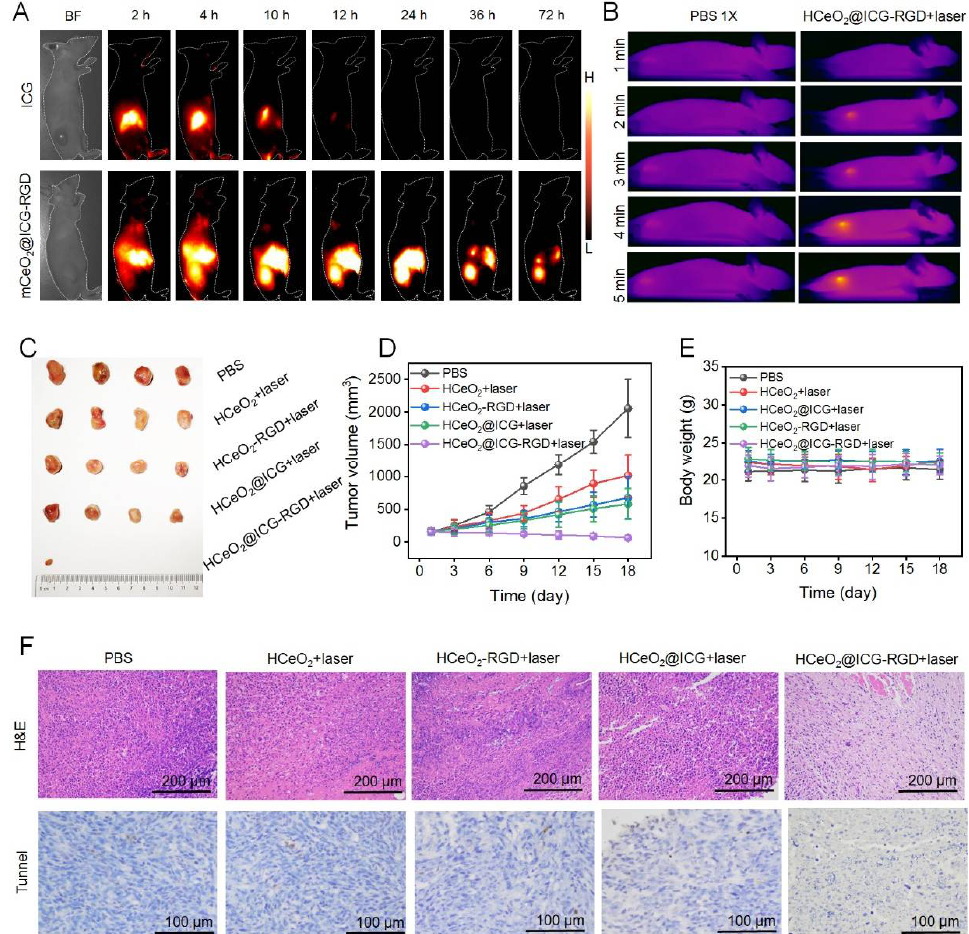
Figure 5. ( A ) NIR II fluorescent images of 4T1 breast tumor-bearing nude mice after tail vein administration of ICG or HCeO 2 @ICG-RGD at various times. ( B ) IR thermal images of 4T1 breast tumor-bearing nude mice under 808 nm laser (1 W cm −2 ) irradiation for different durations. Two groups of BALB/c nude mice were pretreated with tail vein administration of PBS or HCeO 2 @ICG-RGD at 24 h. ( C ) Digital image of dissected solid breast tumors after 18 days of treatment with PBS, ICG+laser, HCeO 2 -RGD+laser, HCeO 2 @ICG+laser, and HCeO 2 @ICG-RGD+laser. Tumor volume curves ( D ) and body weights measurement ( E ) of 4T1 breast tumor-bearing nude mice after PBS, ICG+laser, HCeO 2 -RGD+laser, HCeO 2 @ICG+laser, and HCeO 2 @ICG-RGD+laser administration for different days. ( F ) H&E and TUNEL staining images of tumor tissues after 7 days of administration with PBS, ICG+laser, HCeO 2 -RGD+laser, HCeO 2 @ICG+laser, and HCeO 2 @ICG-RGD+laser.